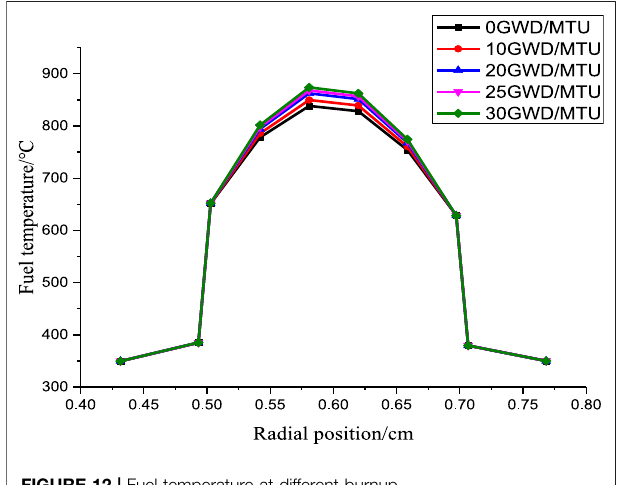
FIGURE 12 | Fuel temperature at different